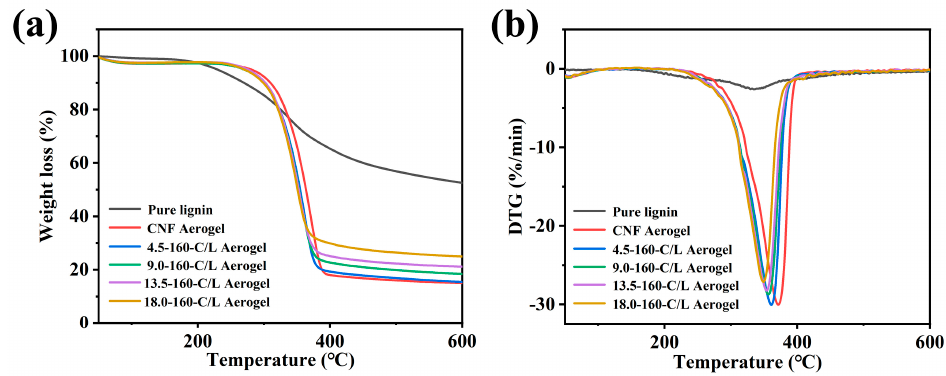
Figure 6. TG ( a ) and DTG ( b ) curves of pure lignin, CNF aerogel and CNF/nano-lignin aerogels.